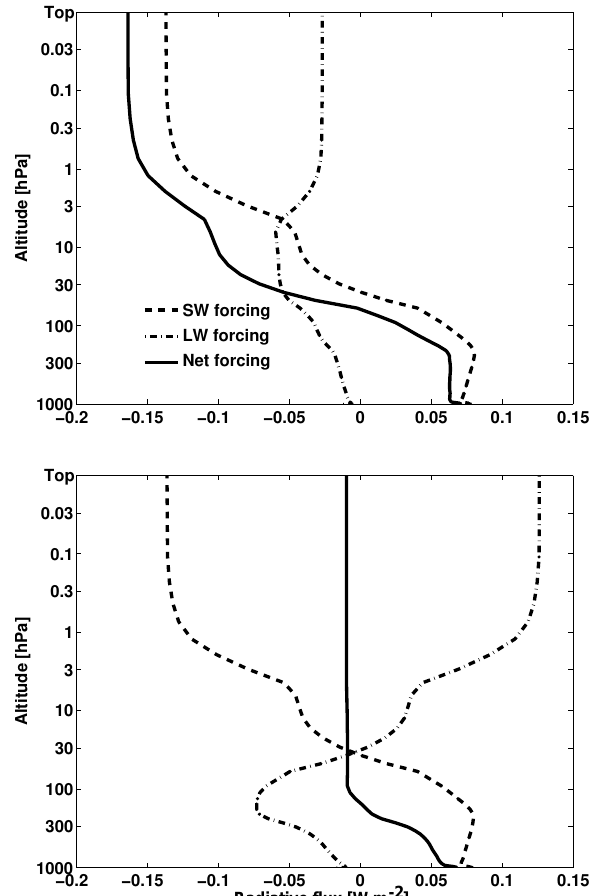
Figure 5. Vertical profile of the global and annual mean net, short- wave, and longwave instantaneous radiative flux change (top) and of the stratosphere-adjusted radiative flux change (bottom) in Wm − 2 , resulting from stratospheric O 3 change between 1980 and 2000.